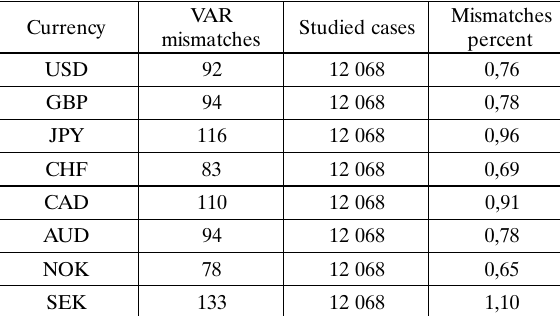
Table 3. The back-testing results of the VaR model